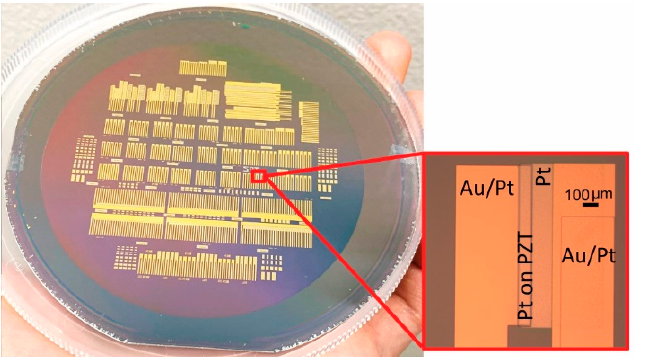
Figure 2. PZT transducer elements, arranged in 1-D arrays, as well as independently accessed by top and bottom Pt and Au electrodes, are fabricated on a 100 mm Si wafer prior to release. A close-up of an individual element is shown in the inset.